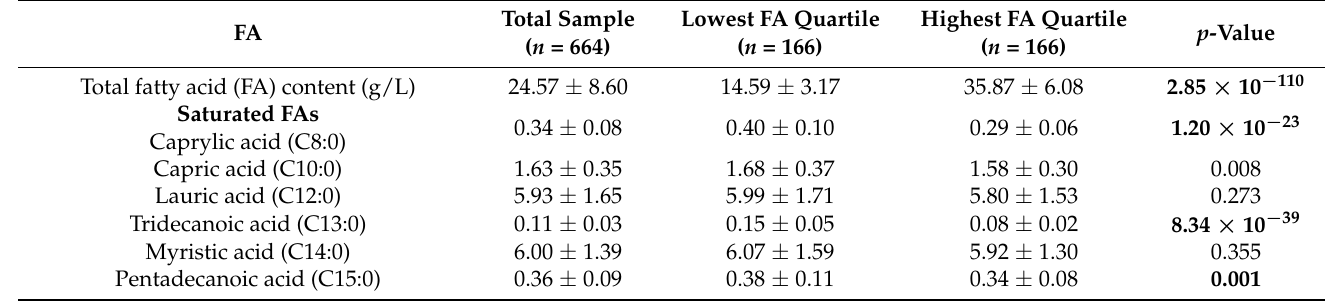
Table 1. Fatty acid percentages (mean ± SD) of the total studied HUMIS milk samples and samples in the lowest and highest quartiles of total FAs; p -values are derived from t -tests comparing the